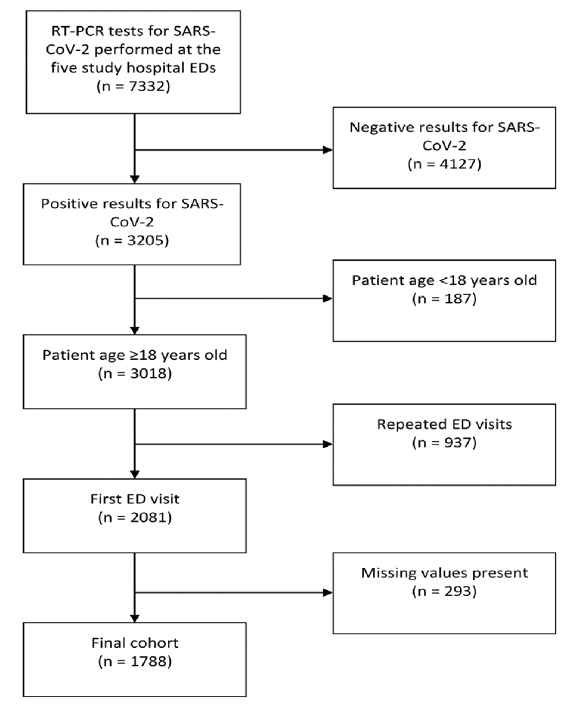
Figure 1. Patient inclusion